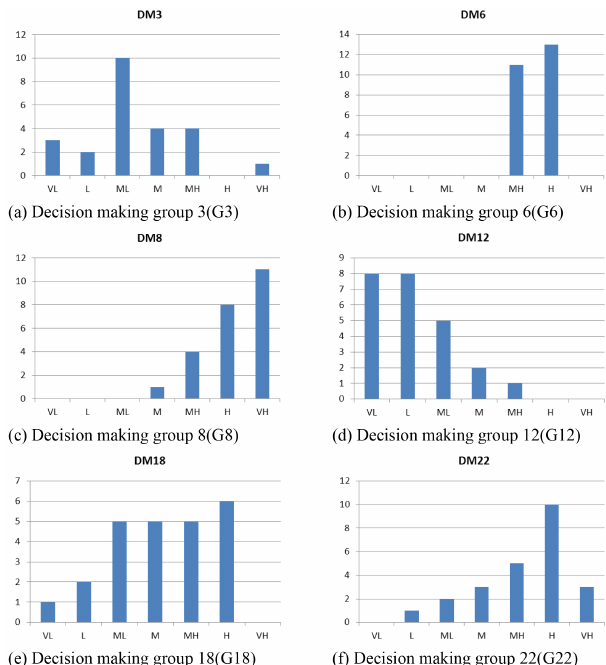
Figure 4. Analysis of linguistic weight of each decision making group.